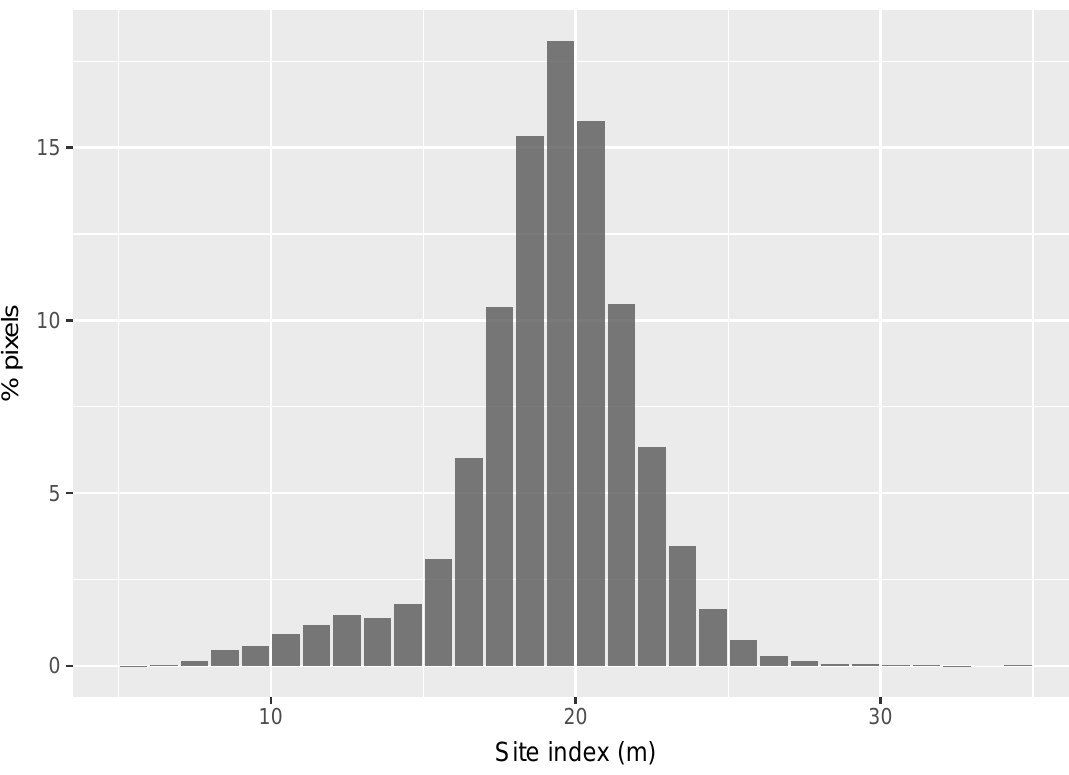
Figure 8. The distribution of site index values over the surveyed landscape (based on 50,000 sample points taken from the ALS coverage region of Figure 4). The site index distribution had a median value of 19.4 m, the 5th percentile value of 13.0 and the 95th percentile value of 23.3 m. The point-level SI values were aggregated to the HU level (Figure 9). The Kruskal–Wallis test and the Steel–Dwass all-pairs test indicated that all pairs of HUs had statistically significant differences in their mean site index values. One can see in Figure 9 that most of the HUs had SI values between 15.1 and 26.0 A distinct divide can be noticed with respect to the ecoregions. That is, almost all the high site index HUs were in the coastal plains (near the eastern coast) while almost all the low site index HUs were on the west side of the study area, in the southeastern plains ecoregion. This may indicate that coastal plain soils and climatic conditions are better suited for loblolly pine growth. HUs that have lower site index seemed to cluster together, possibly indicating that their performance was more strongly linked to broad geographic reasons, rather than site-specific management